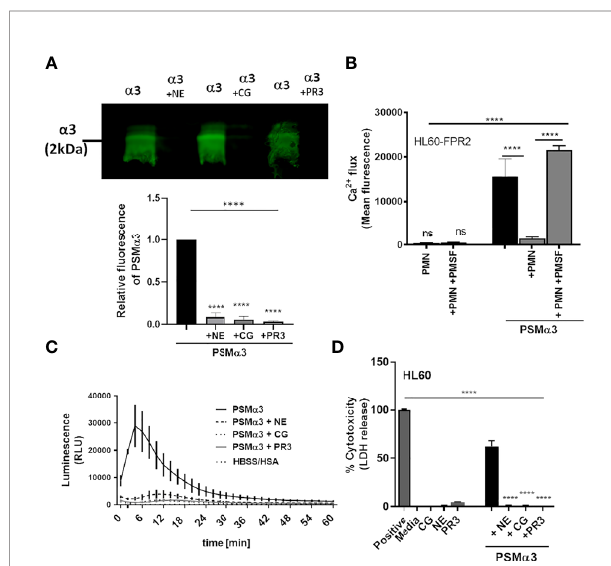
FIGURE 3 | NSPs degrade PSM a 3. Addition of NSPs NE, CG or PR3 results in degradation of PSM a 3 (A) . Incubation of neutrophils with the NSP inhibitor PMSF prevents inhibition of PSM a 3-mediated FPR2 activity (B) . Inactivation of PSM a 3 by NE, CG or PR3 prevents oxidative burst of neutrophils (C) and leads to loss of cytotoxicity (D) . Data represent mean +/-SEM of three independent experiments (A – D) . ns, not signi fi cant; ****P < 0.0001 signi fi cant difference versus untreated control (A) , the neutrophil-treated control (B) or the PSM a 3-treated control (D) as calculated by one-way ANOVA with Dunnett ’ s multiple comparisons test (A – D)